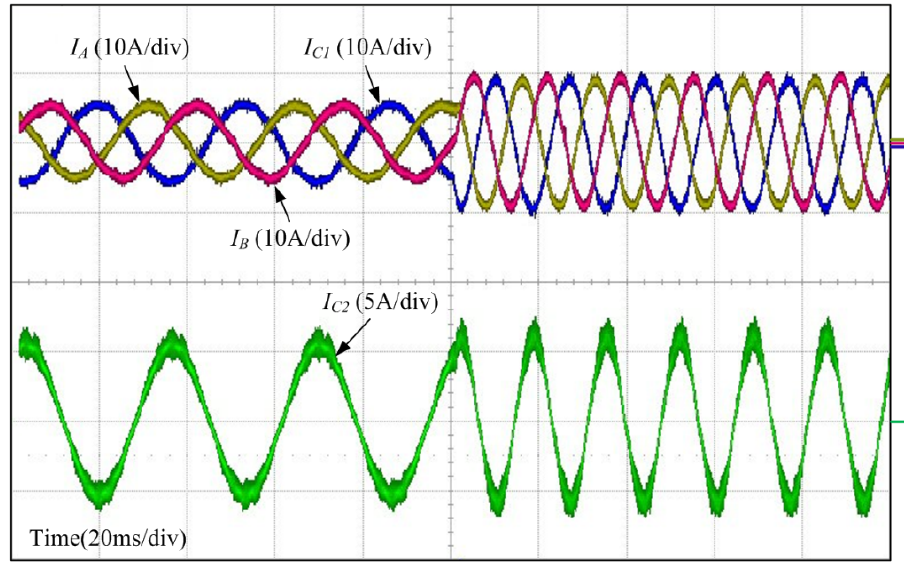
Figure 17. Experimental waveforms of the output currents with the dual outputs.